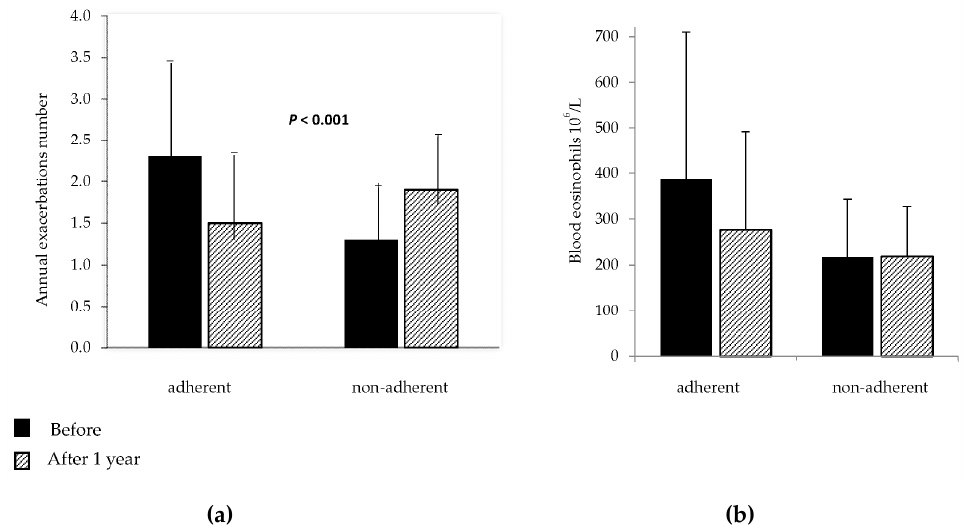
Figure 3. Mean values with standard deviation of annual exacerbations number. ( a ) and blood eosinophils count; ( b ) before and after vitamin D supplementation in patients adherent and non-adherent to vitamin D supplementation.